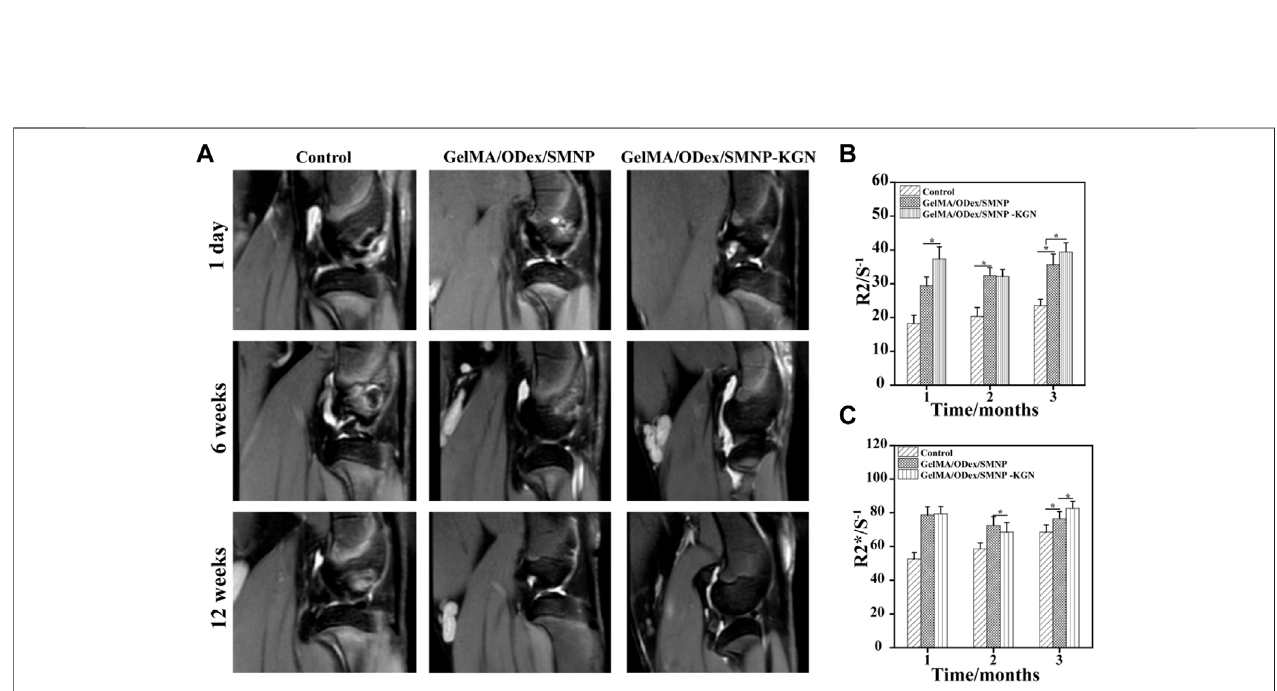
FIGURE 6 | (A) In vivo T2-weight MR image of articular cartilage. (B) R2/S-1 and (C) R2*/S-1 value obtained from MR images.